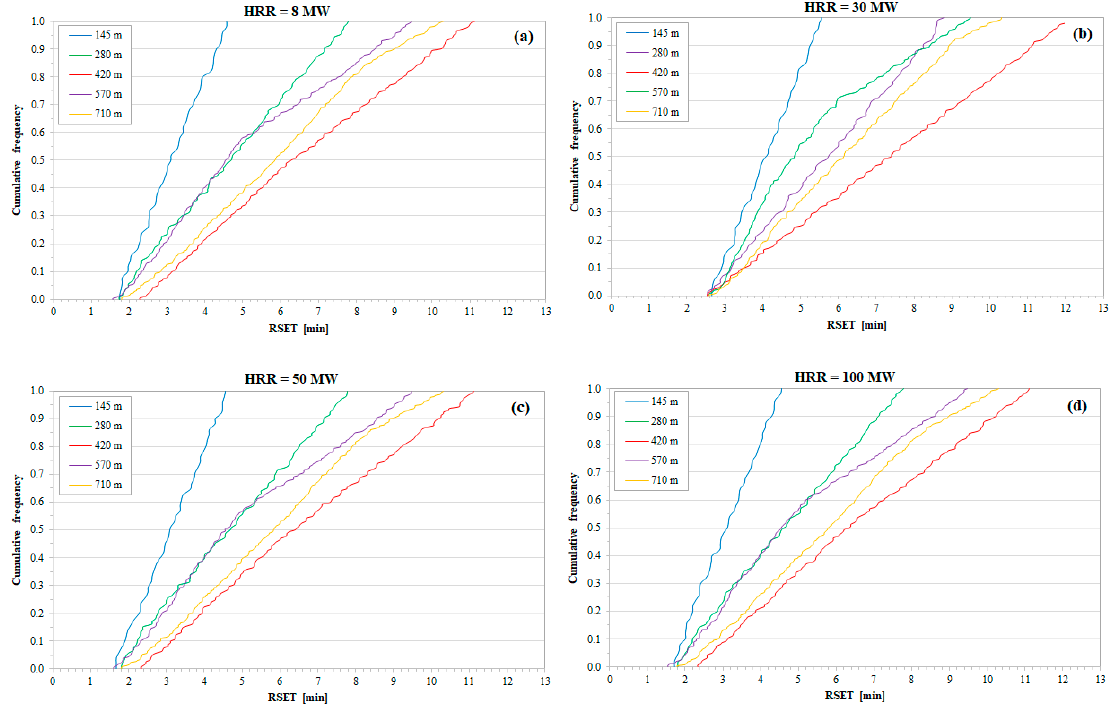
Figure 8. Cumulative frequency distributions of RSET in the event of: ( a ) 8 MW fire; ( b ) 30 MW fire; ( c ) 50 MW fire; ( d ) 100 MW fire, and for the five different positions of fire within the tunnel investigated.